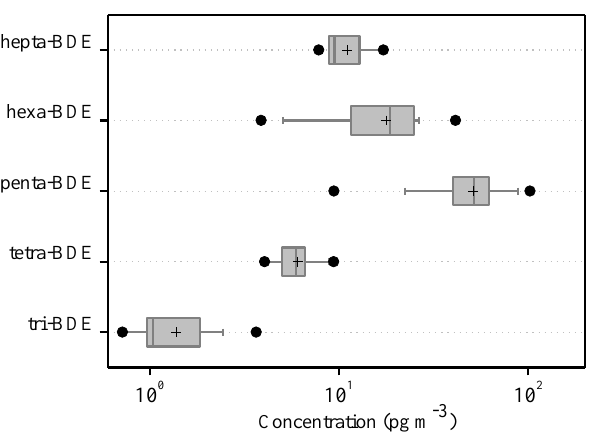
Figure 1. Concentration profiles of PBDE homologue groups in the urban atmosphere. Solid vertical lines and the horizontal lines rep- resent median and mean values, respectively. Box plots represent 25th–75th percentiles; whiskers indicate 5th and 95th percentile. The solid circles represent maximum and minimum values.